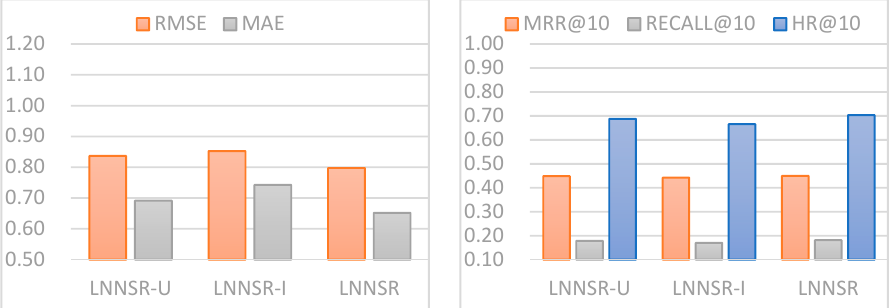
Figure 5. Effect of user’s attribute information and item’s attribute information on the MovieLens- 1M dataset.